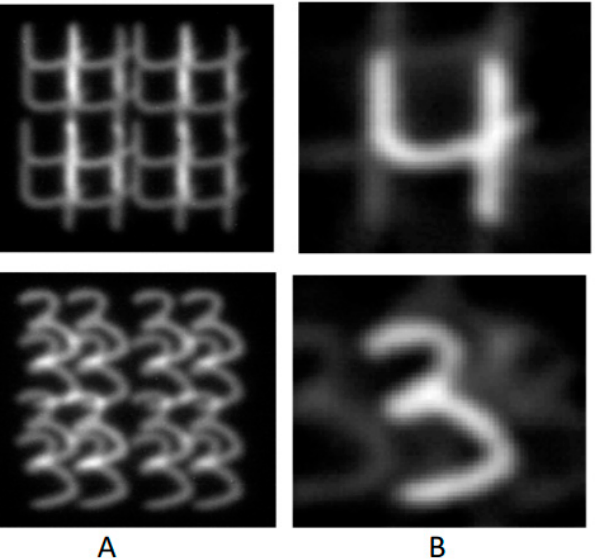
Figure 4. ( A ) Obtained image on the detector and ( B ) the same image after using inverse Wiener